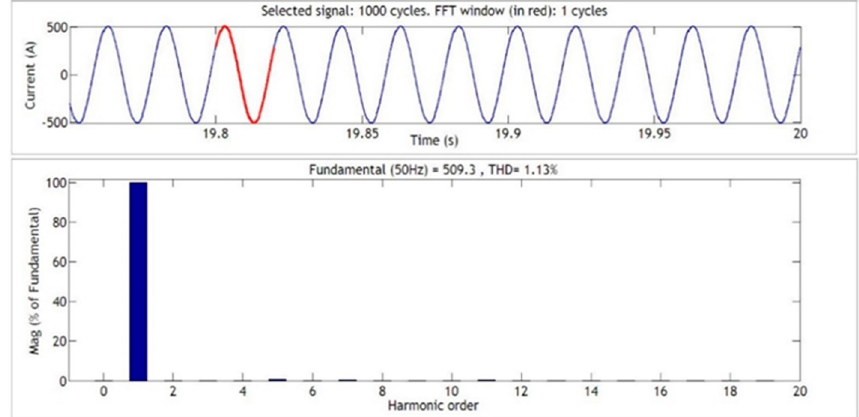
Figure 21. After compensation unbalanced system source current FFT analysis. Table 2. Source current total harmonic distortions (THDs).